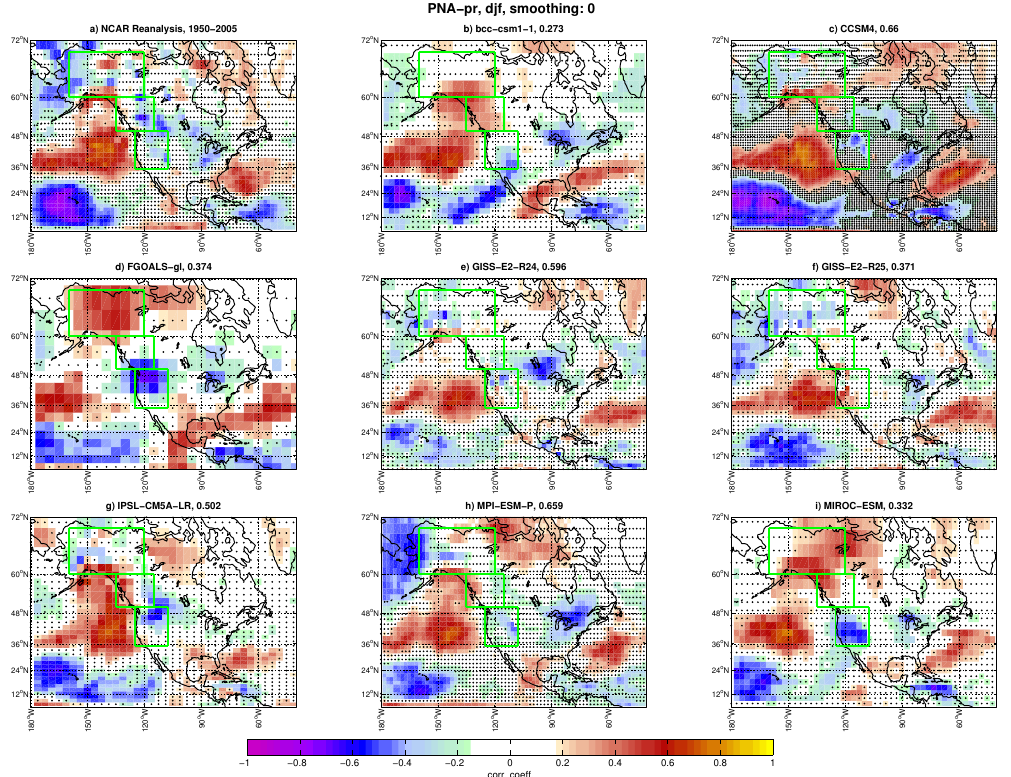
Figure 3. Observed and simulated correlation maps between the winter PNA index and winter precipitation time series for the period 1950– 2005. Dots mark grid points where the correlation is not significant at 95% confidence accounting for autocorrelation. The green boxes mark the areas used for the TT2010 reconstruction. In panels (b–i) , the numbers reported in the respective titles are the spatial correlations between observed and simulated patterns calculated for the shown land-only domain north of 12 ◦ N (to this end, NCAR data were regridded to the model